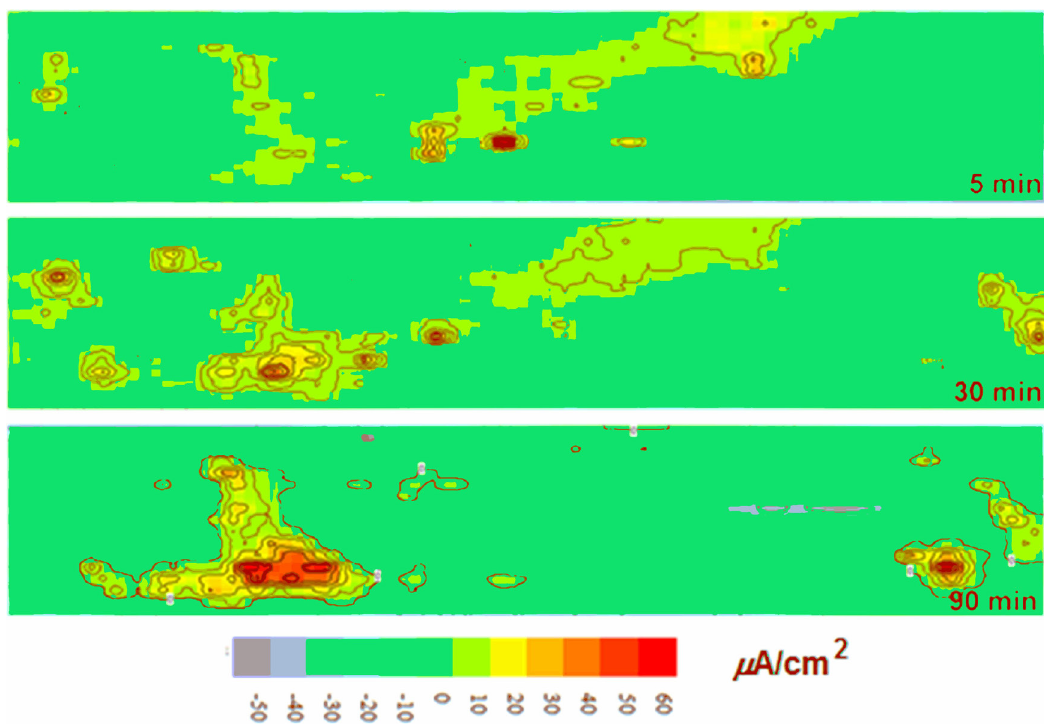
Figure 7. SVET ionic currents maps obtained for SAE 1008 carbon steel after 5, 30 and 90 minutes of immersion in 0.001 mol L -1 HCl solution.